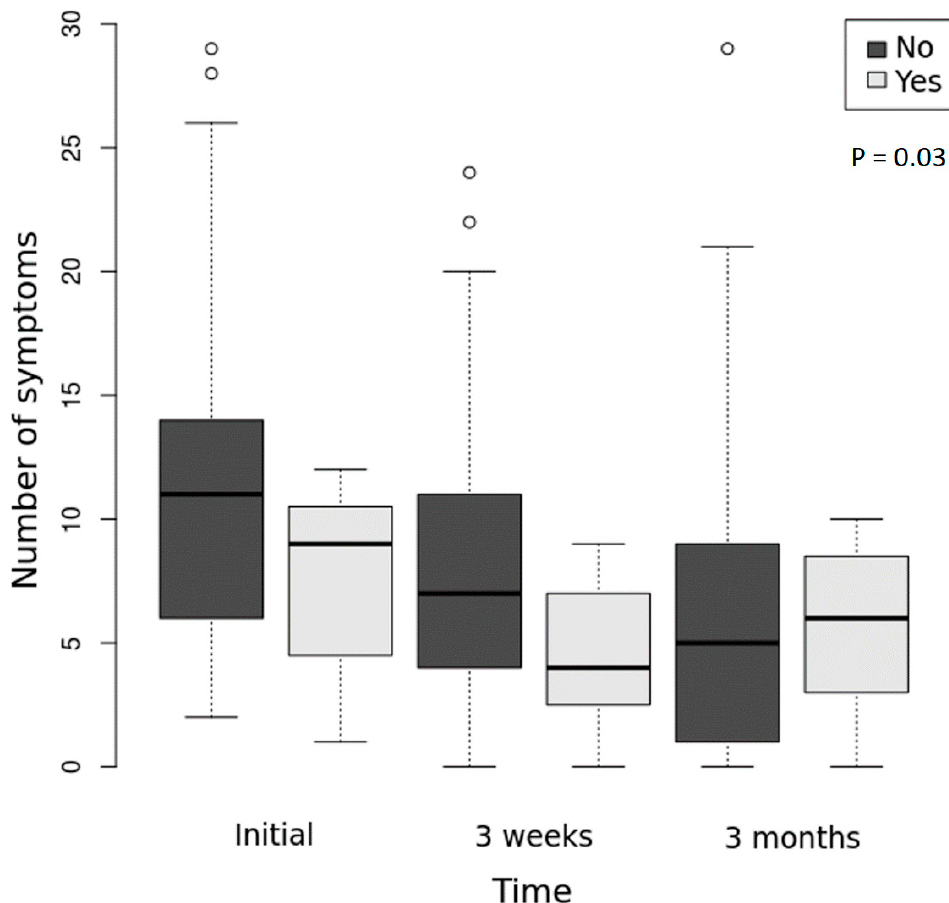
Figure 1. Evolution of the number of symptoms in the two groups (possible LNB versus invalidated LNB) during the follow-up. Box represents median observations (horizontal rule) with 25th and 75th percentiles of observed data (top and bottom of box). The length of each whisker is 1.5 times the interquartile range (Yes = possible LNB; No = LNB invalidated). The overall differences presented as p -value on the chart, between the two groups, were assessed with a negative binominal mixed effects regression